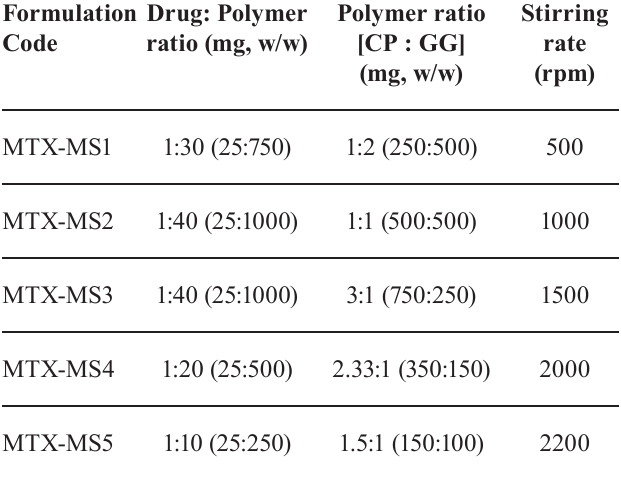
TABLE I – F ormulation of MTX loaded mucoadhesive microparticles